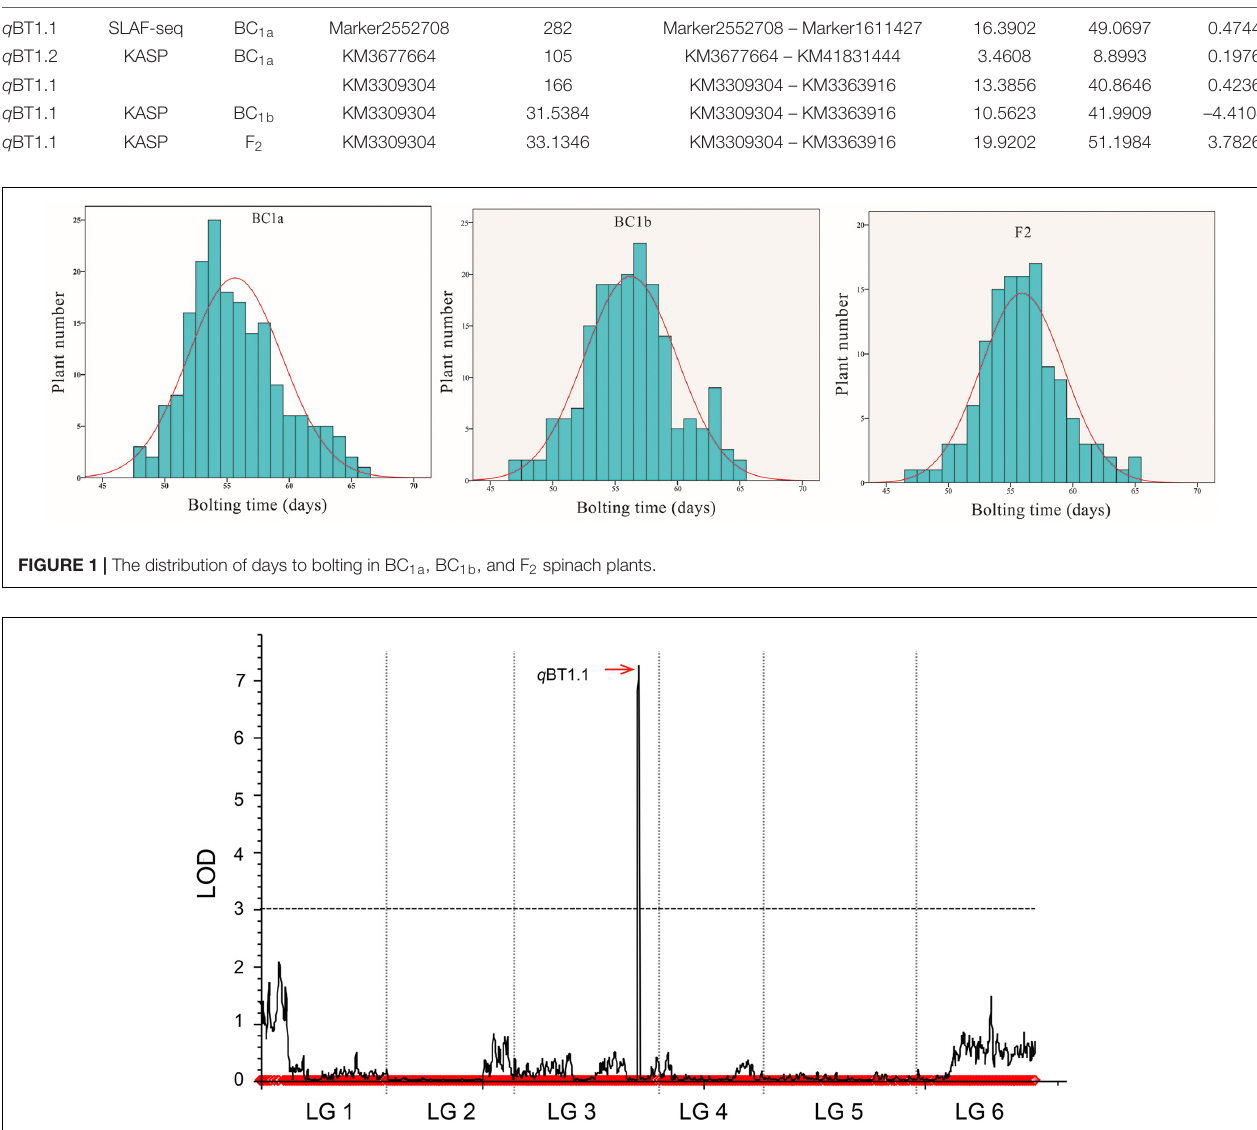
Frontiers in Plant Science |